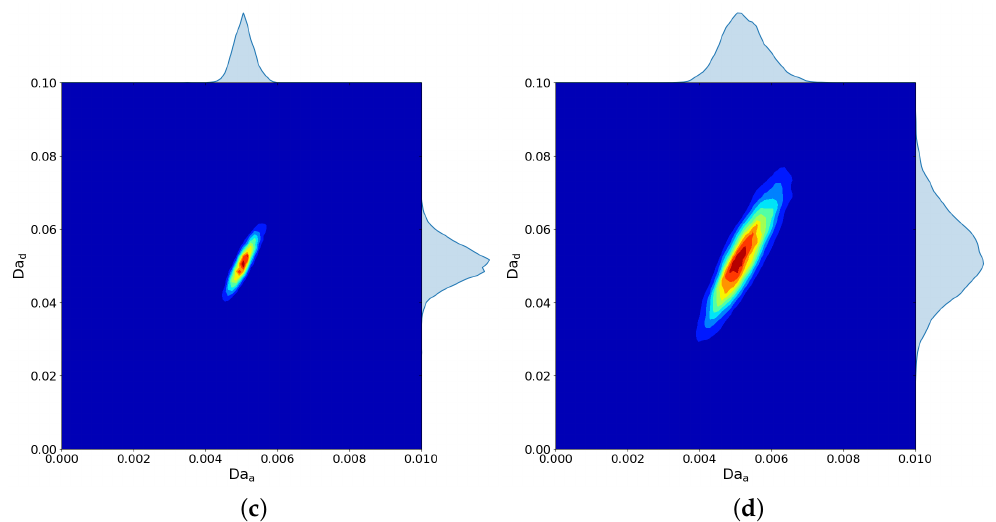
Figure 4. MCMC outputs for AM where results was obtained for: ( a ) measurements with 0.01 noise variance, ( b ) measurements with 0.05 noise variance, ( c ) ten different measurements with 0.01 noise variance, ( d ) ten different measurements with 0.05 noise